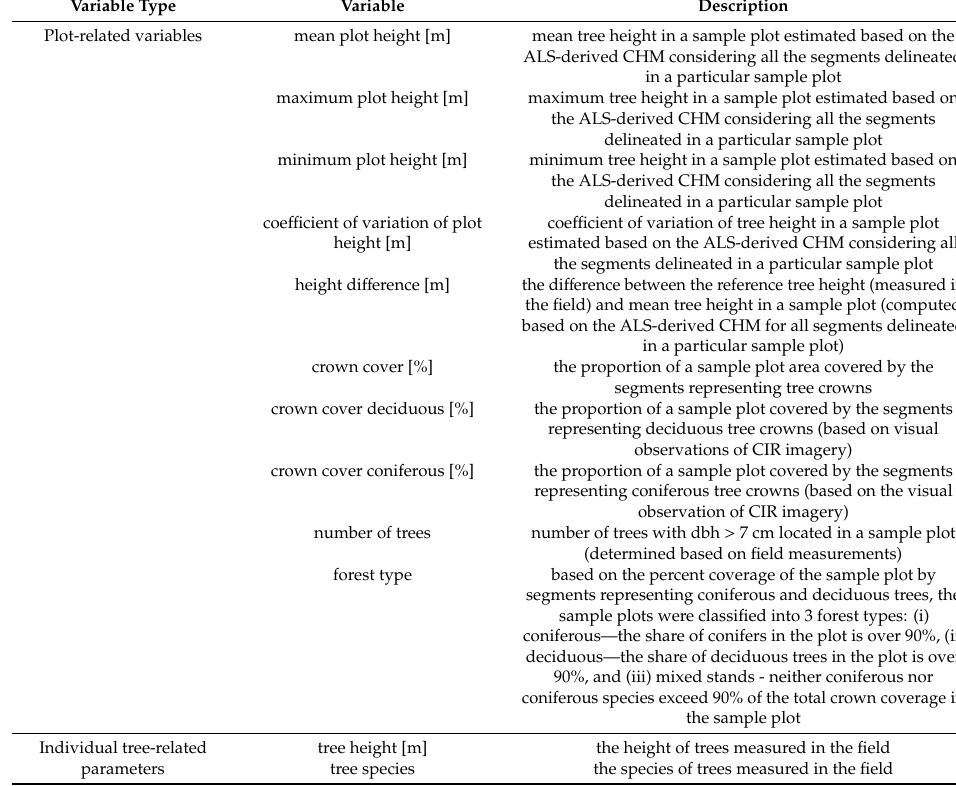
Table 3. Variables considered in the boosted regression trees (BRT)